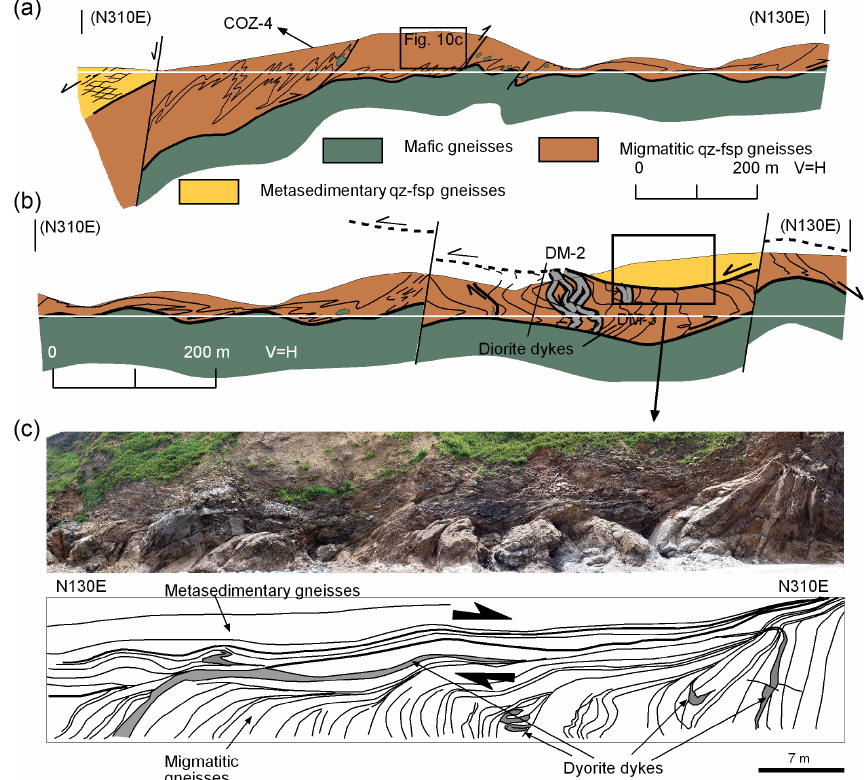
Figure 12. Geological sections showing the internal structure of the migmatitic qz-fsp gneisses and the locations of larger eclogite-blocks. Cross sections are located in Fig. 2a. The white lines represent the sea level. (a) In the northern section, the internal structure is characterized by asymmetrical folding and the presence of eclogite block-in-matrix close to the thrust. (b) The internal structure of the migmatitic qz-fsp gneisses is dominated by the presence of polyclinal folds bounded by the basal thrust and the upper normal detachment. (c) Photograph and sketch in the cliff of the Serrón beach showing an extensional detachment placing the metasedimentary gneisses on top of the migmatitic gneisses. Location of the sections is in Fig. 2a.